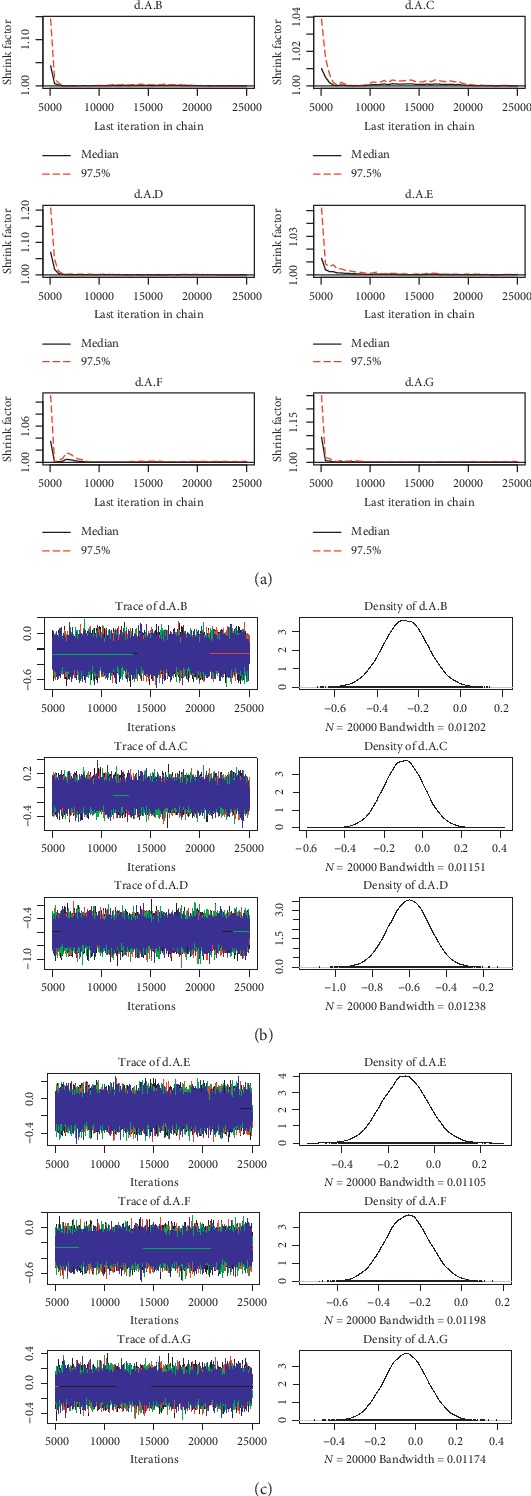
Brooks-Gelman-Rubin diagnostic plot and density plot for the safety of the comparison among different treatments of patients with mild renal function.